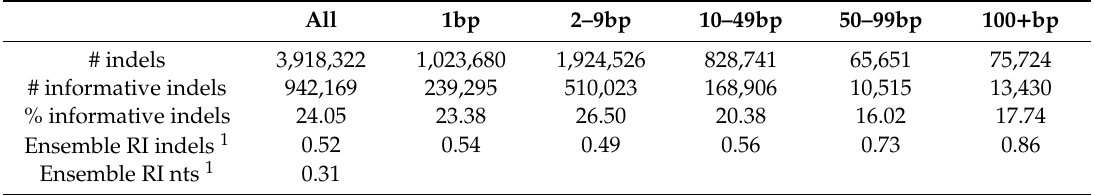
Table 2. Intron indel number, information content, and parsimony consistency by size class.